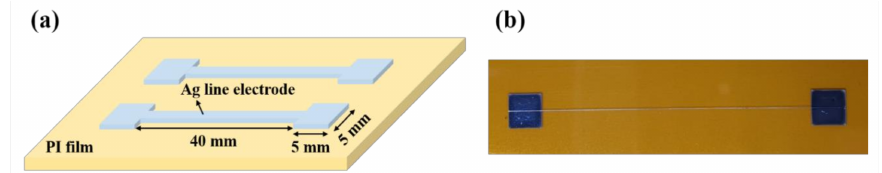
Figure 1. ( a ) Schematic diagram of the silver electrode designed for inkjet printing, and ( b ) Optical image of the silver electrode